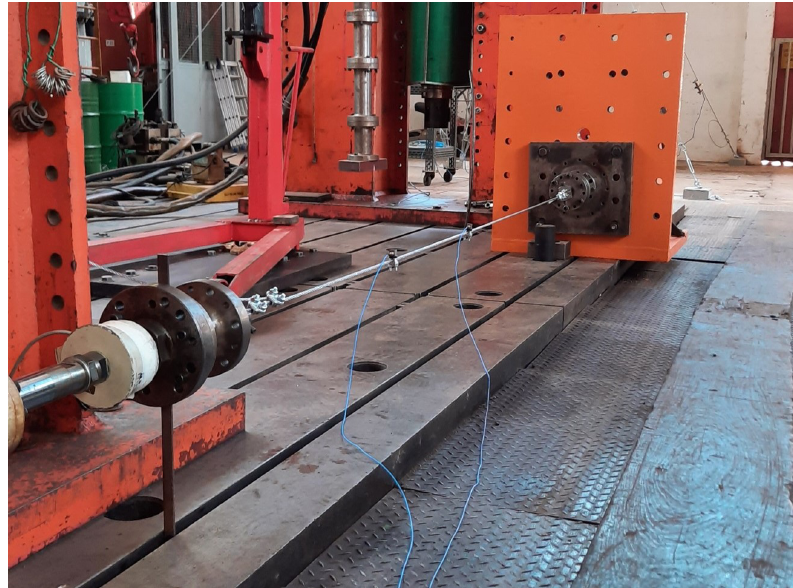
Figure 2. Device used for testing the stay cable of the mockup tower.